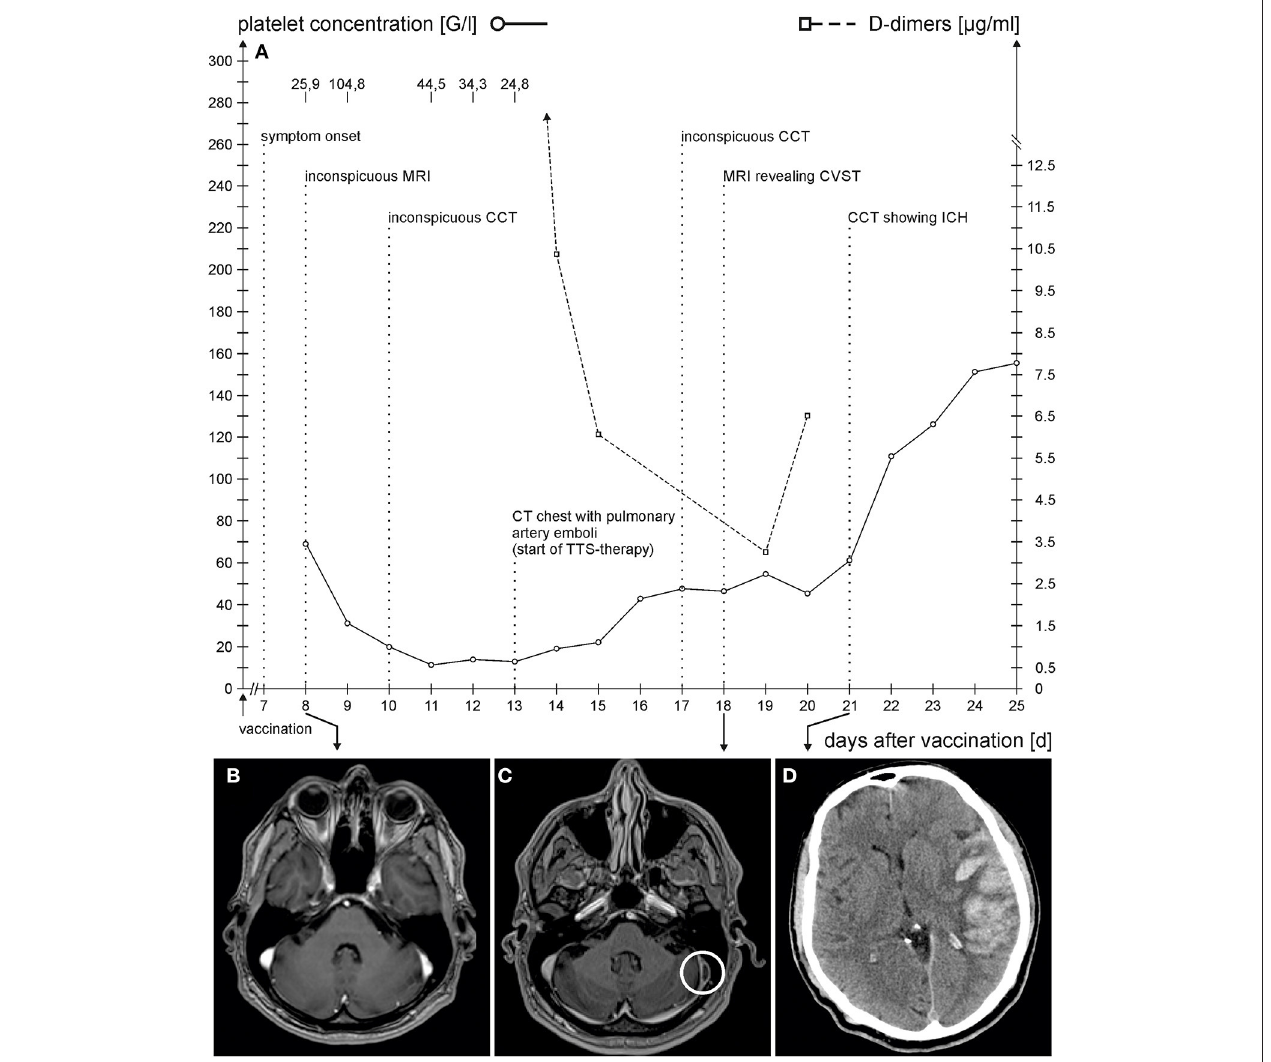
FIGURE 2 | (A) Time course of symptom onset, laboratory findings of platelet count (solid line)/D-Dimer (dashed line), and imaging studies. The x-axis represents the number of days after vaccination. (B,C) show axial contrast-enhanced T1-weighted MRI-sequences: (B) no evidence of thrombosis in the left-sided lateral transverse sinus at day 8 following vaccination; (C) thrombosis in the left-sided lateral transverse (circle) sinus at day 18 following vaccination; (D) axial cranial CT showing a left-sided, space-occupying atypical intracranial hemorrhage (ICH) with subarachnoidal hemorrhage at day 21 following